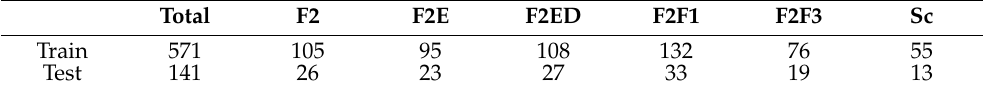
Table 2. Number of samples in the training set and the test set, with respect to the six classes.